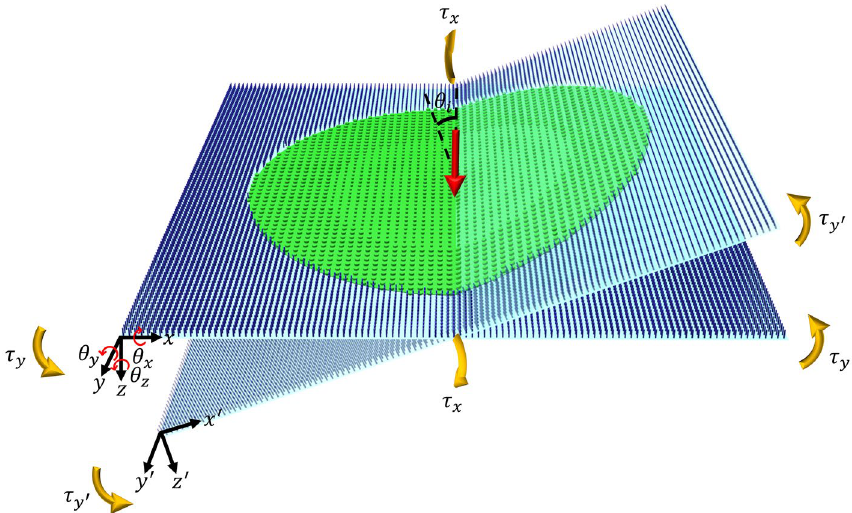
Figure 3. The optomechanical analysis framework for calculating the imparted optical forces in the local coordinate system (primed) and transferring it to the global coordinate system, enabling the linear stability analysis and estimation of motion trajectory in the propulsion period. Generated by Autodesk 3ds